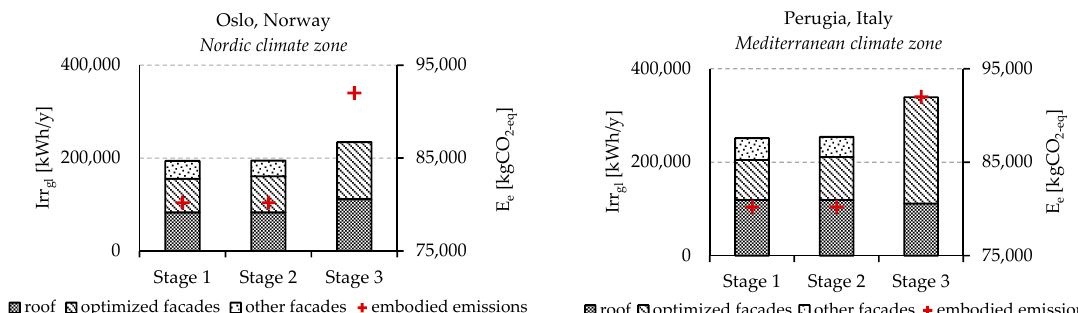
Figure 4. Trend and values of global solar incident irradiation and emissions embodied in materials throughout the optimization process about Oslo and Perugia. In both Step 1 and Step 2 —box-shaped model—the exposure of two contiguous façades was optimized. In Step 3 , the whole envelope was enhanced, thus the graphs report a null value for the bar of “other façades”.